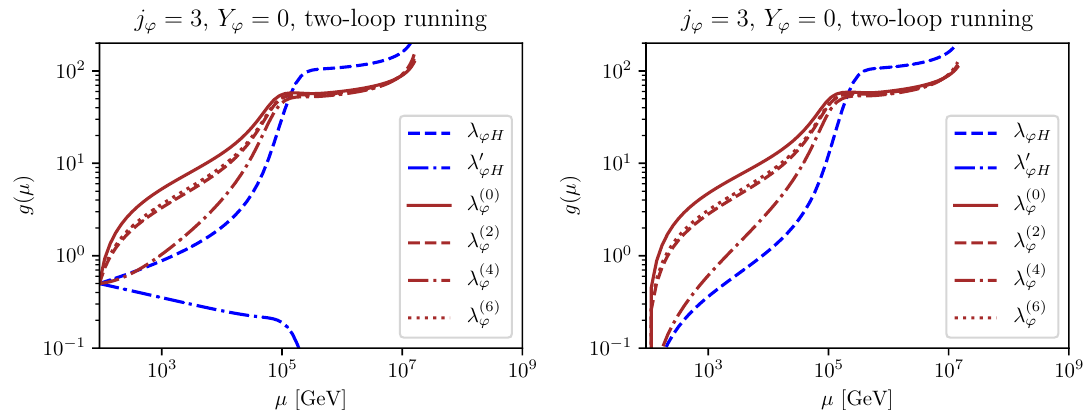
Figure 6. Two-loop running of scalar quartic couplings for j ’ = 3 with Y ’ = 0. The notation is the same as in (cid:12)gure 5.